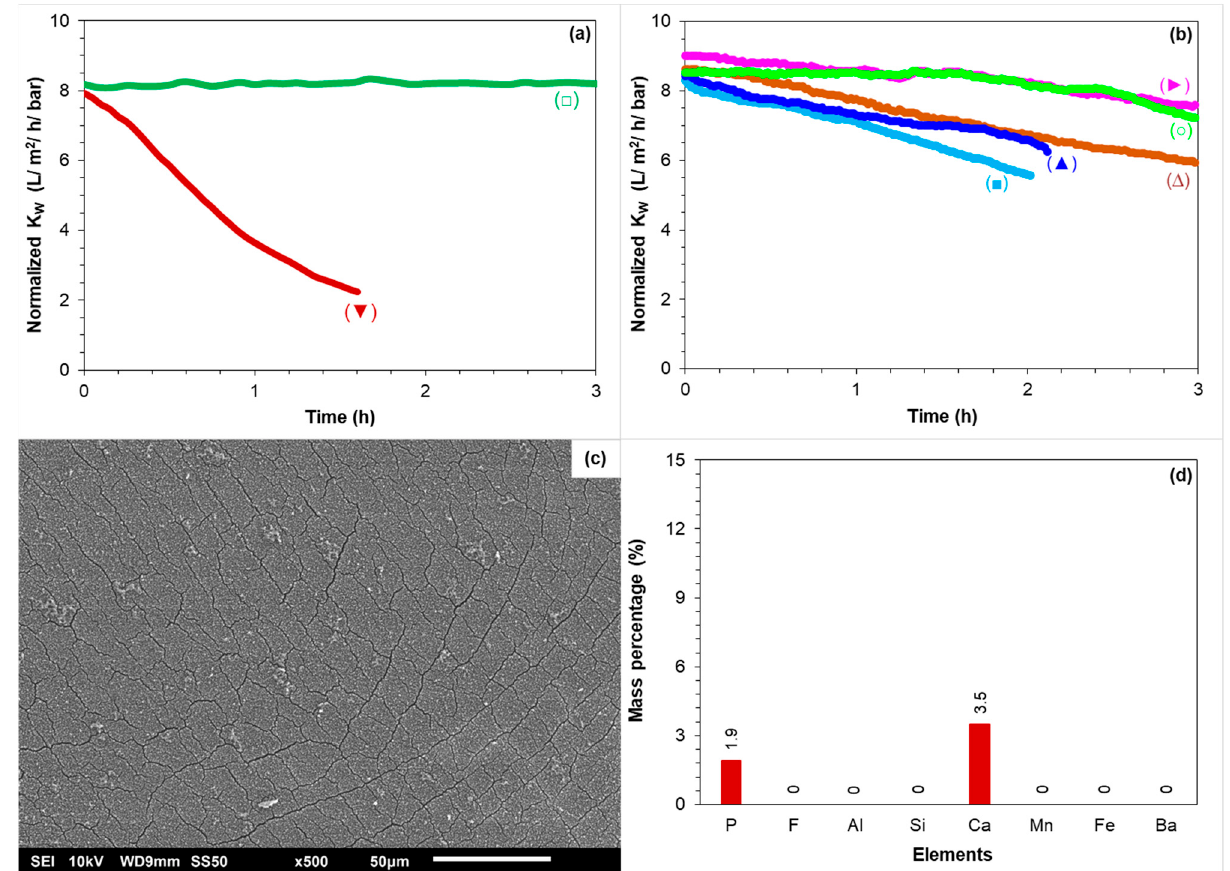
Figure 10. ( a ) Normalized K w of the small RO element when fed with the synthetic concentrates of ( □ ) 80% recovery without antiscalant and ( ▼ ) 85% recovery without antiscalant. ( b ) Normalized K w of the small RO element when fed with the synthetic concentrates of 85% recovery with 33.3 mg/L of ( ■ ) AS–1, ( ▲ ) AS–2, ( ○ ) AS–3, ( ∆ ) AS–4, and ( ► ) AS–5. ( c ) SEM image of the membrane surface fouled with calcium phosphate without antiscalant addition. ( d ) EDX analysis of the membrane fouled with calcium phosphate without antiscalant addition.